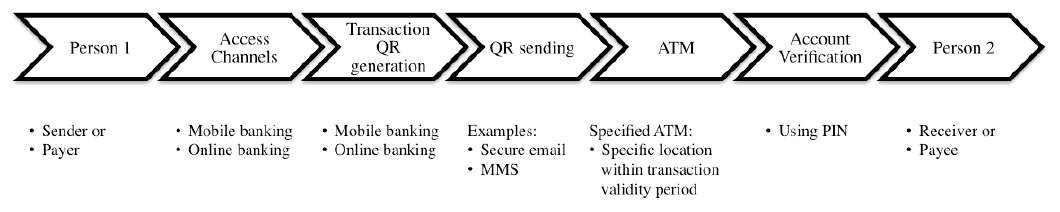
Figure 6. QuickCash Offline transaction life